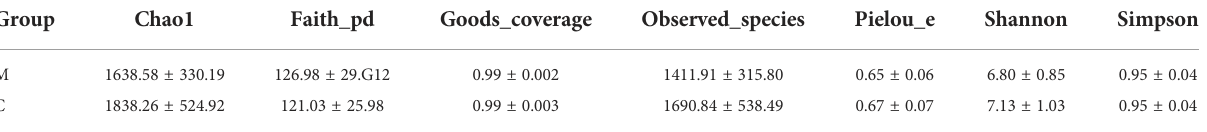
TABLE 2 Comparison of species alpha diversity based on ASV levels.